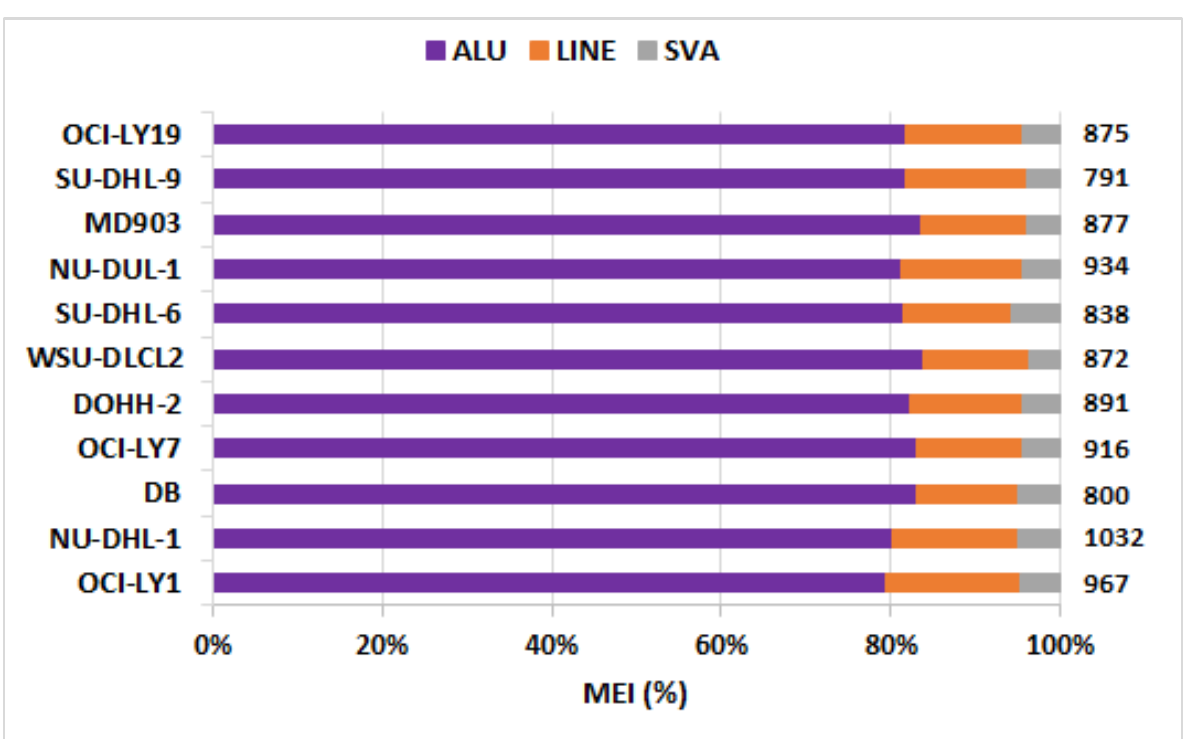
Figure 2. Fraction of three classes of mobile element insertions (MEIs), viz., ALU, LINEs, and SVA. Total number of MEIs per cell line is indicated on the right panel.